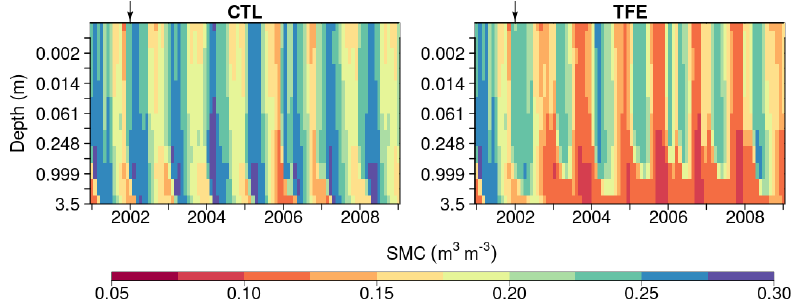
Figure 5. Soil moisture content (SMC) simulated by ORCHIDEE-CAN-NHA during 2001–2008 under CTL and TFE. It should be noted that the 12 soil layers have different thicknesses and here we show the SMC in the same depth interval to present the change in SMC in top layers